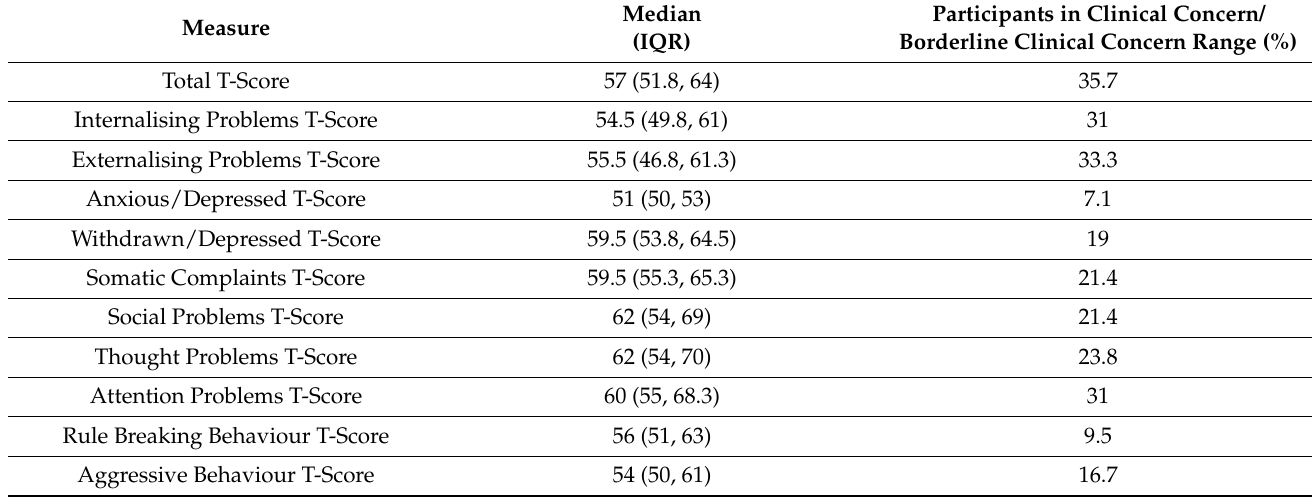
Table 4. Child Behaviour Checklist (CBCL) data for participants ( n =